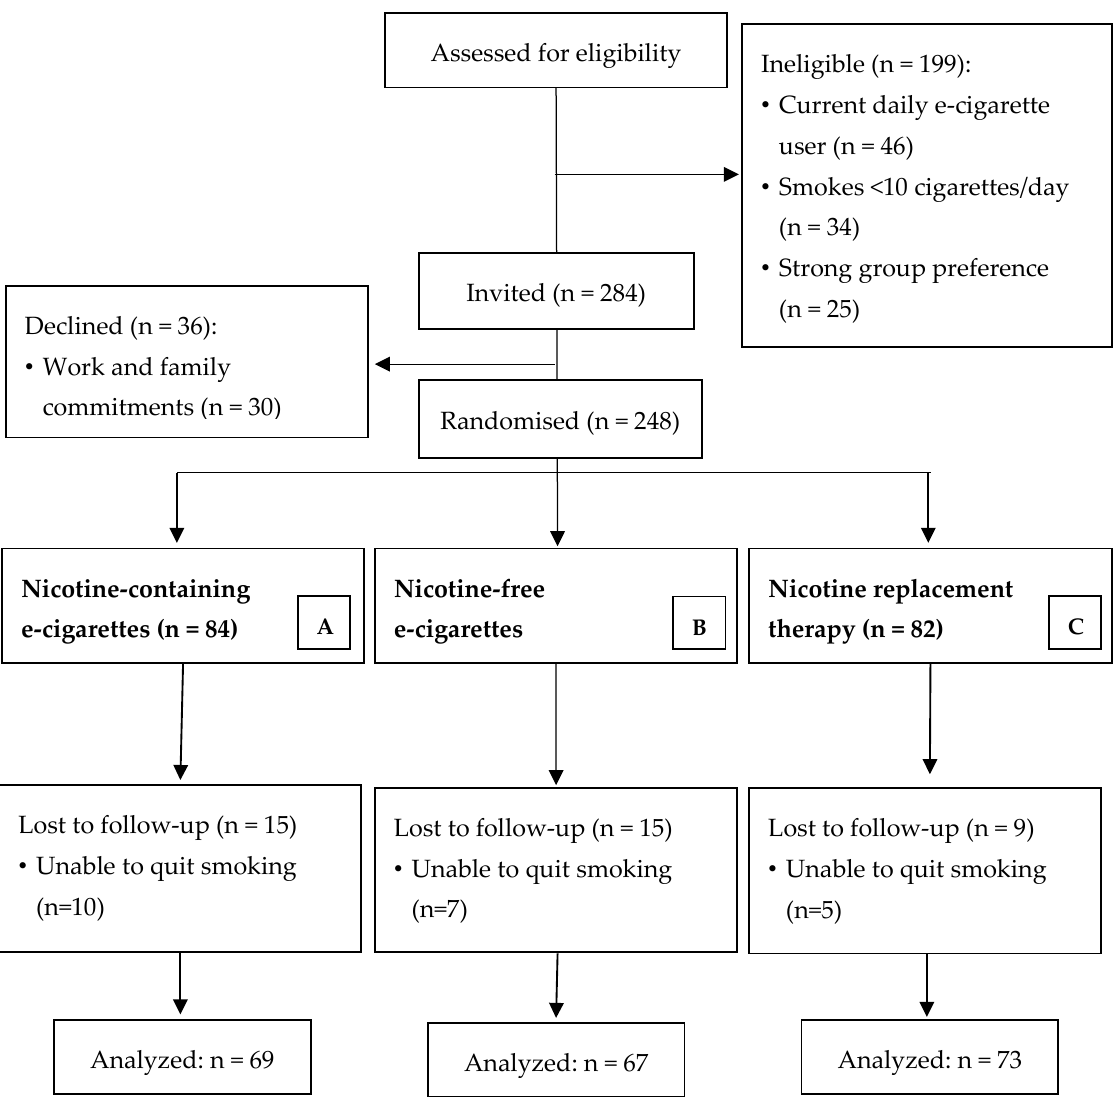
Figure 1. Flowchart of the Study Population. Table 1. Sample description, n = 248.